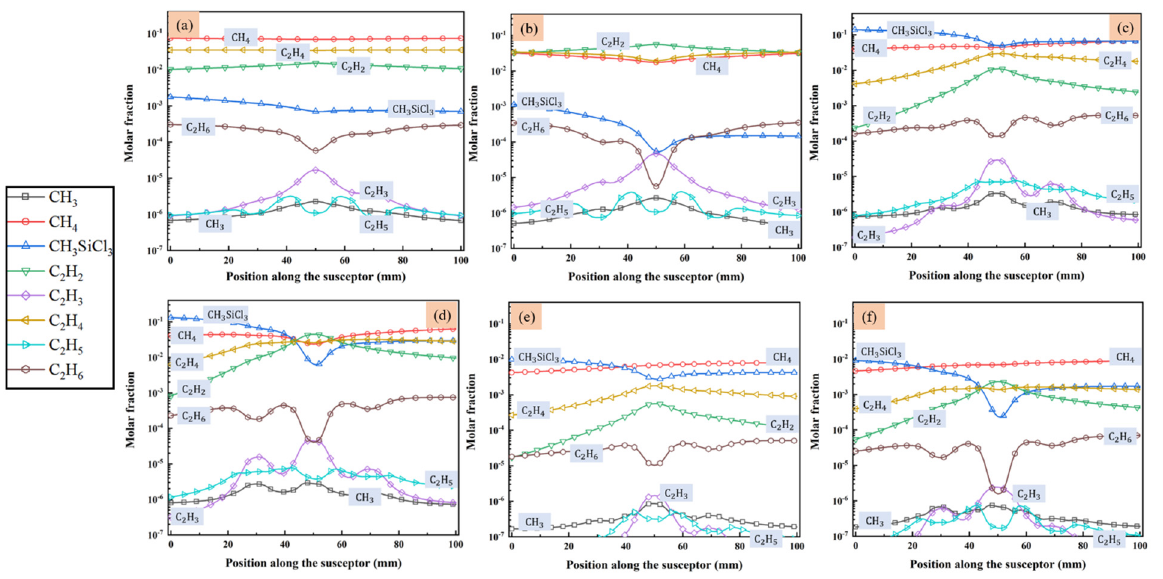
Figure 4. The molar fraction of main species that contained C in the gas phase above the susceptor: ( a ) case 1; ( b ) case 2; ( c ) case 3; ( d ) case 4; ( e ) case 5; and ( f ) case 6.